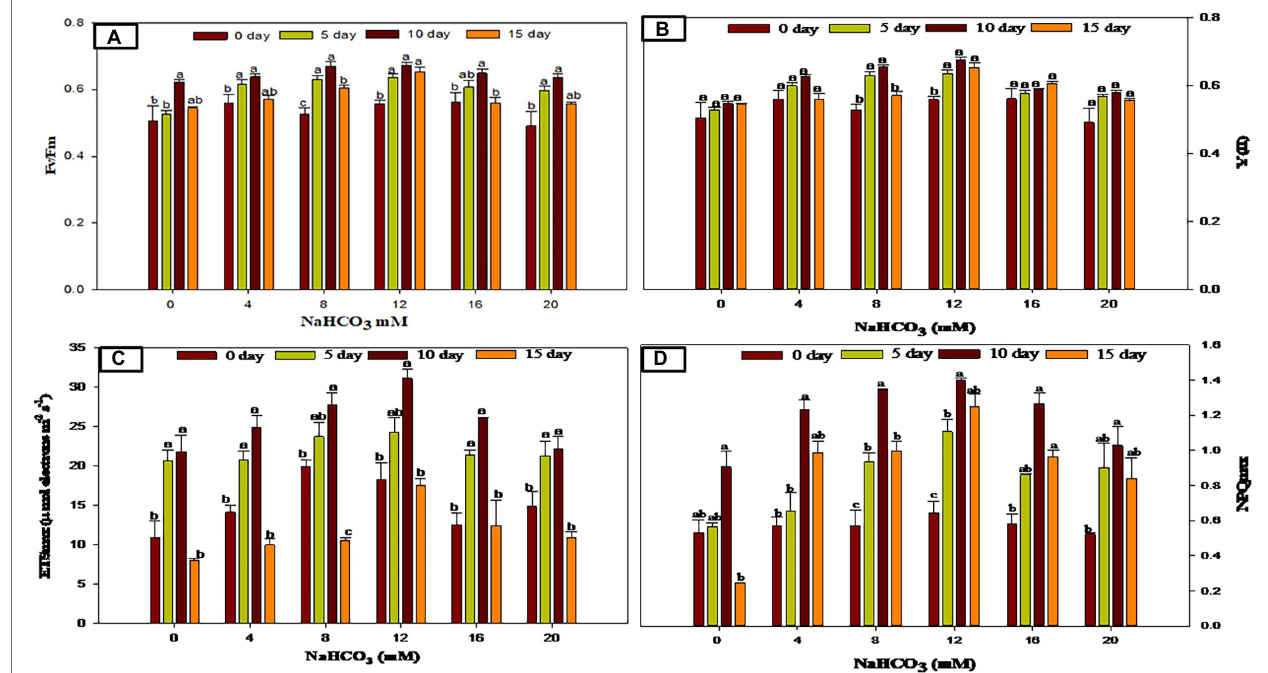
FIGURE 5 | Chlorophyll fluorescence and photosynthetic performance in Scenedesmus sp. BHU1 with various NaHCO 3 concentrations at different days. Bars are mean ± SE of three replicates. Bars adhered with different alphabets (a, b, and c) are statistically significant at p < 0.05 (Tukey’s-b post hoc